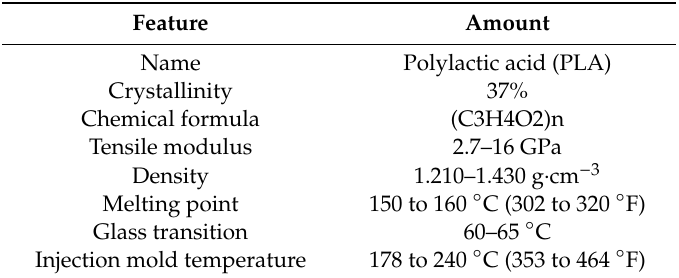
Table 4. Specification of polylactic acid (PLA).